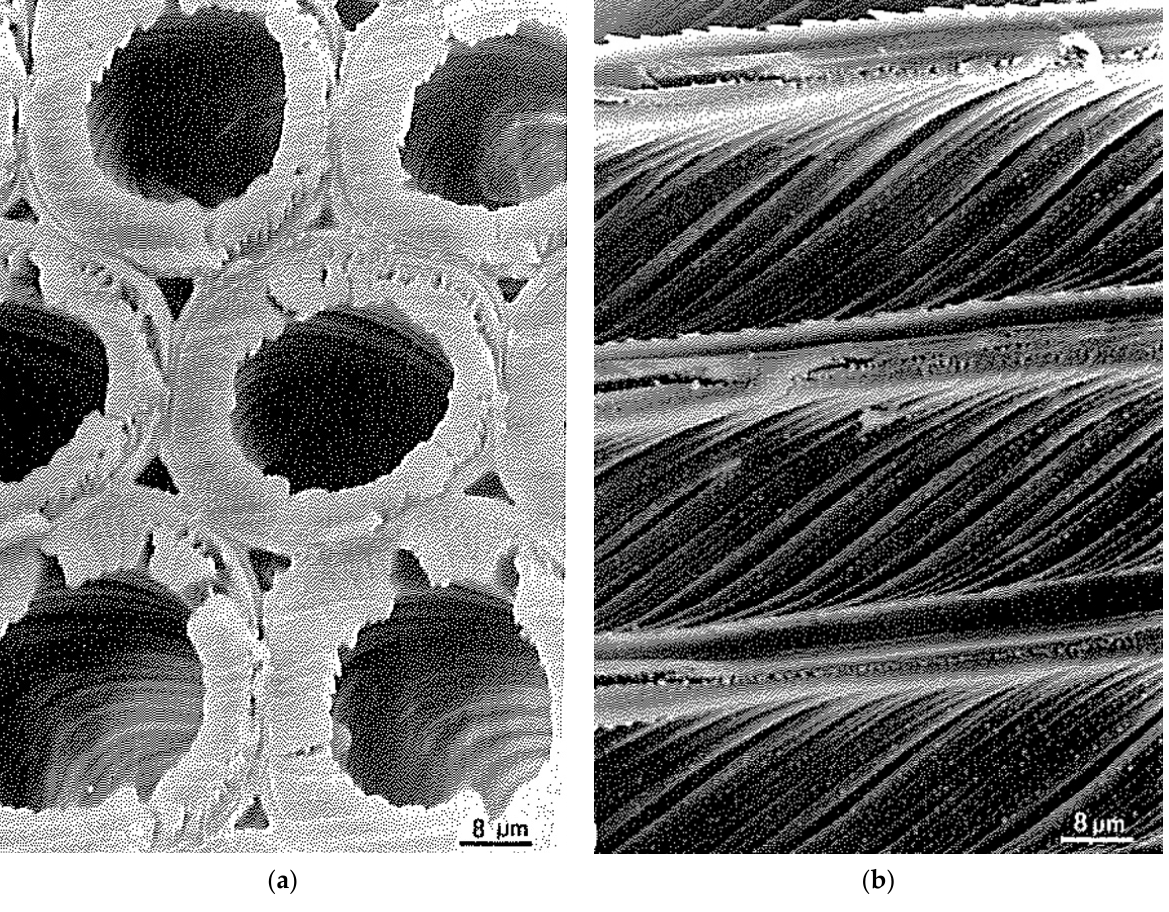
Figure 1. Electron micrographs of tracheids in the xylem of Radiata Pine ( Pinus radiata ). ( a ) Transverse section. ( b ) Longitudinal section. From [11].